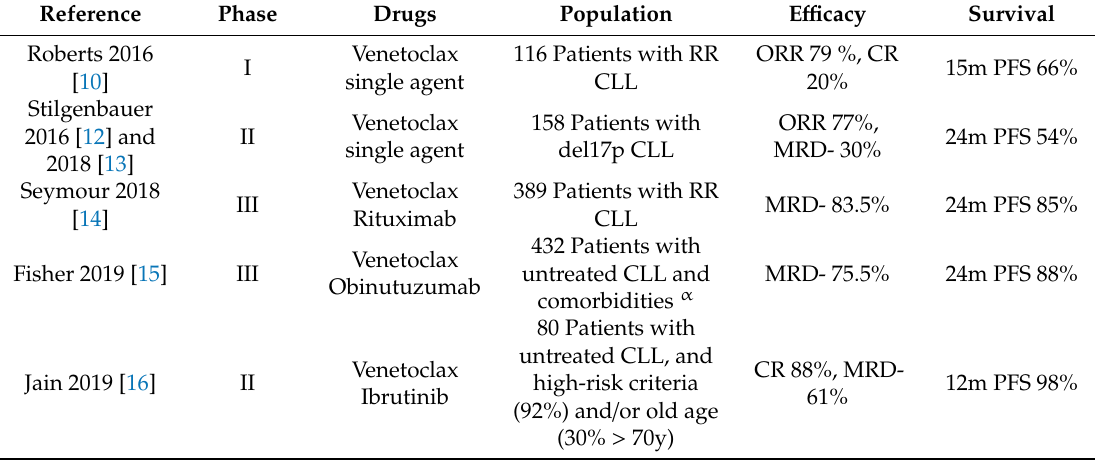
Table 1. Results from clinical trials evaluating venetoclax single agent or in combination in CLL